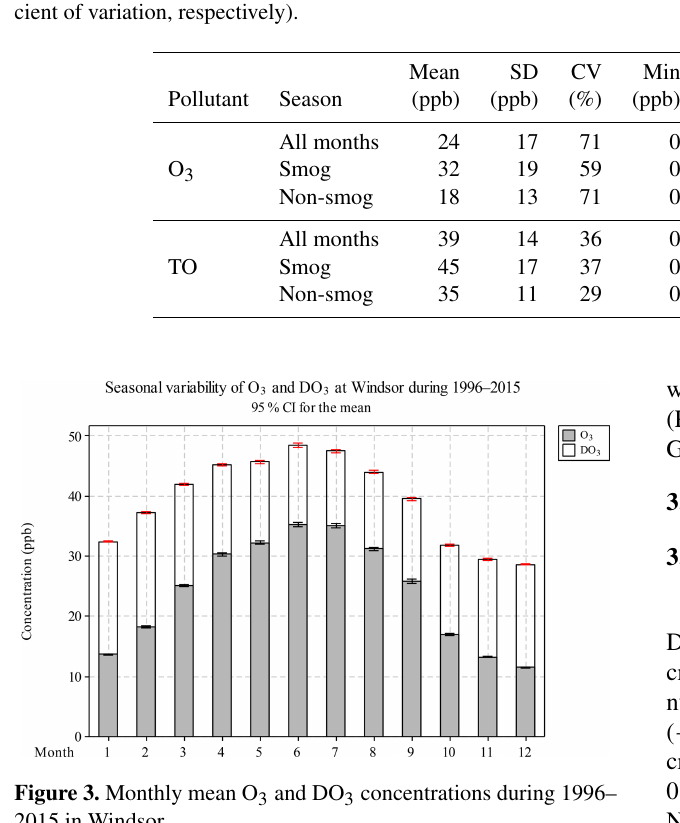
Table 1. General statistics of O 3 and TO concentrations in Windsor during 1996–2015 (SD and CV stand for standard deviation and coeffi- cient of variation, respectively).